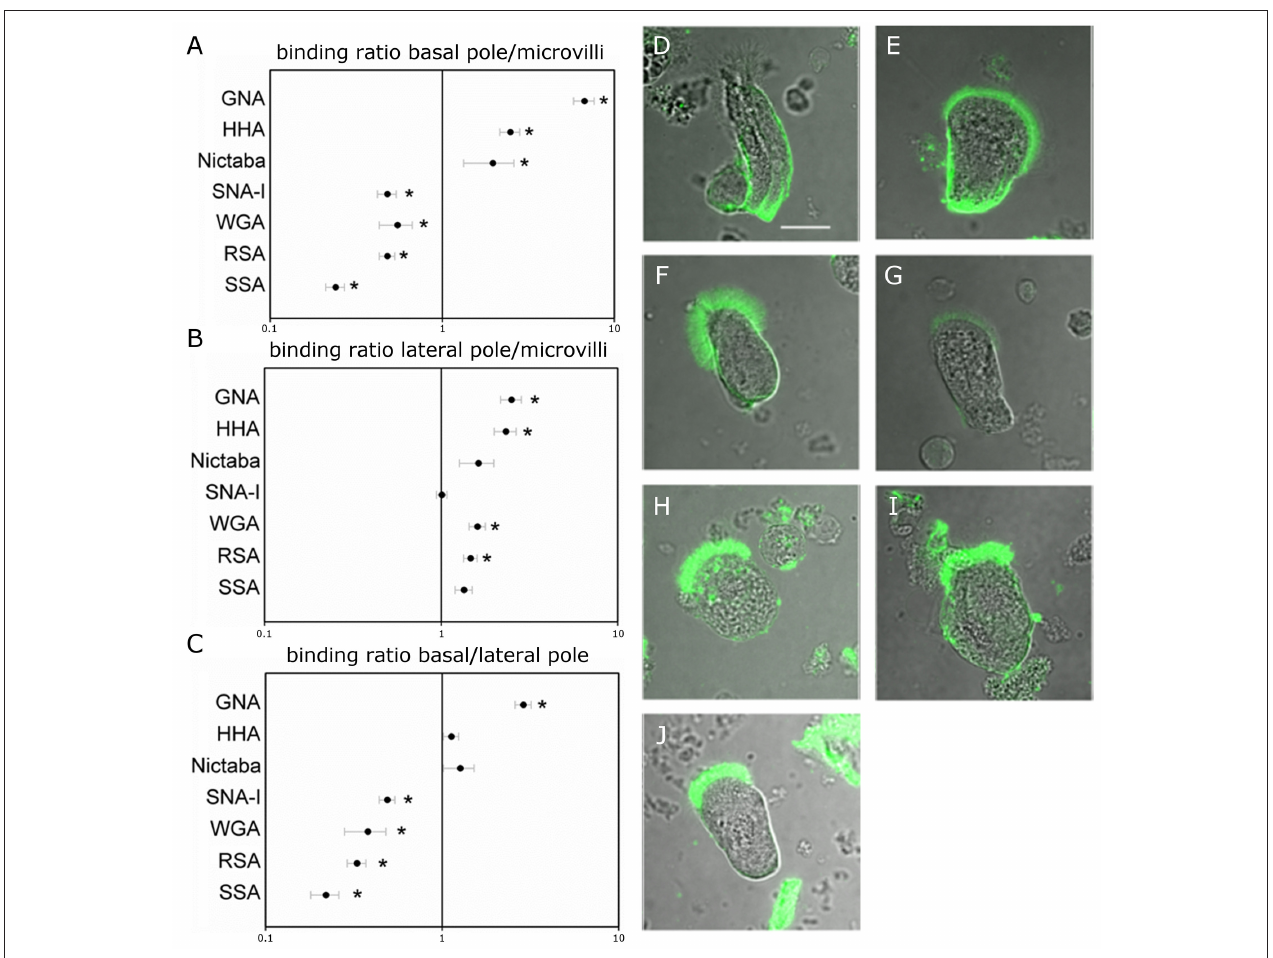
FIGURE 1 | Lectin binding to different regions on the surface of the midgut columnar cells of Spodoptera littoralis . (A,B) Ratio of FITC-labeled lectin binding to basal (A) or lateral (B) zones over the binding intensities to microvilli suggest that glycans recognized by SSA, RSA, WGA, and SNA-I are more abundant at the microvillar zone while those recognized by Nictaba, HHA, and GNA are more abundant at the basal poles. Data are presented as average values ± SEM. Asterisks indicate statistically significant differences ( p < 0.05, independent sample t -test). (C) Comparison between the basal and lateral parts of the cell membranes indicates differential binding for WGA, RSA, HHA, and GNA. Data are presented as average values ± SEM. Asterisks indicate statistically significant differences ( p < 0.05, independent sample t -test). (D–J) Representative confocal images of midgut columnar cells incubated with FITC-labeled lectins: GNA (D) , HHA (E) , Nictaba (F) , SNA-I (G) , WGA (H) , RSA (I) , and SSA (J) . Pictures of the cells are oriented to show the microvillar zone at the top. Scale bar is 20 µ m.